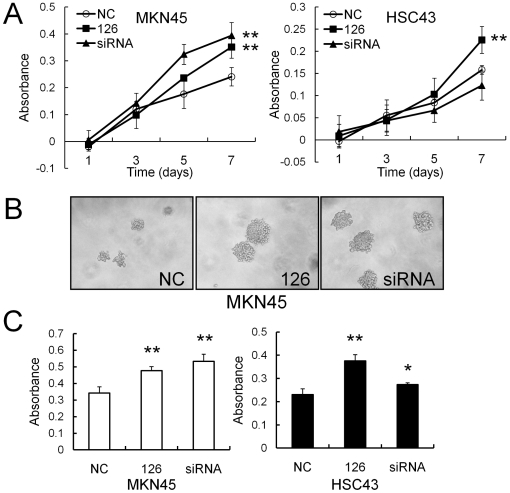
Effects of miR-126 expression on anchorage-dependent and -independent cell growth.(A) In vitro cell proliferation assays after SOX2 knockdown by Pre-miR-126 or siRNA in gastric cancer cell lines. The number of viable cells was determined with a Cell Counting Kit-8 on days 1, 3, 5 and 7 after plating. (B) Representative phase contrast microphotographs of the colonies of MKN45 cells in soft agar at 9 days after transfection of the negative control, Pre-miR-126 or SOX2 siRNA. Original magnification: ×100. (C) Soft agar colony formation assays for measurement of the anchorage-independent growth of gastric cancer cell lines. The vertical axis (Absorbance) indicates the relative number of colony-forming cells, which was determined by the colorimetric assay method. The assays were performed in quadruplicate, and the bars indicate s.d. *P<0.05; **P<0.01.